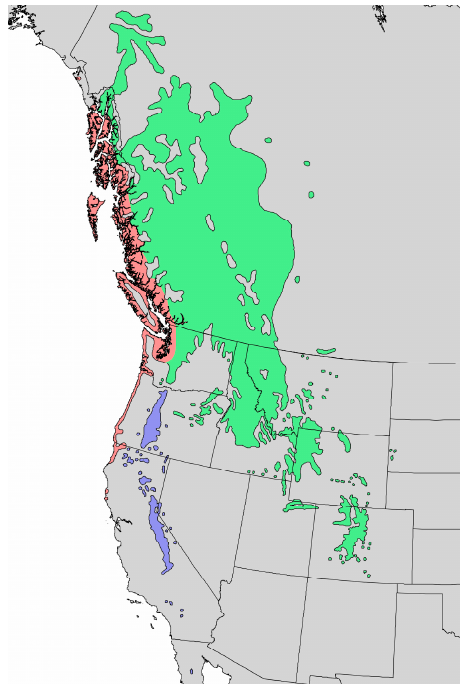
Figure 5. Natural range of Pinus contorta .